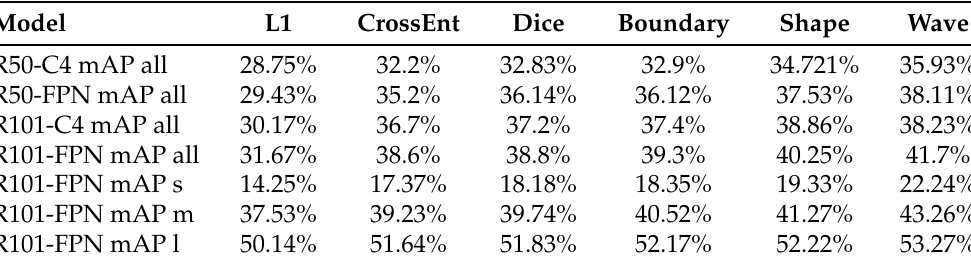
Figure 8. Example results on the COCO dataset segmented with Mask-RCNN; ( a ) cross entropy loss; ( b ) wave loss. Table 2. Average precision results on COCO 2017 validation set using the same network architectures with three different loss functions in different columns ( (cid:96) 1 , cross entropy, Dice loss, active boundary loss, shape aware loss and wave loss). Two different architectures (ResNet-50 and ResNet-101) can be found in the rows, with feature pyramid networks (FPNs) or when the activation of the fourth convolution layer (C4) was used for region proposals. The results display the mean average precision for all objects, except the last three rows, where the accuracy results for the best performing network are detailed for small-, medium- and large-sized objects as